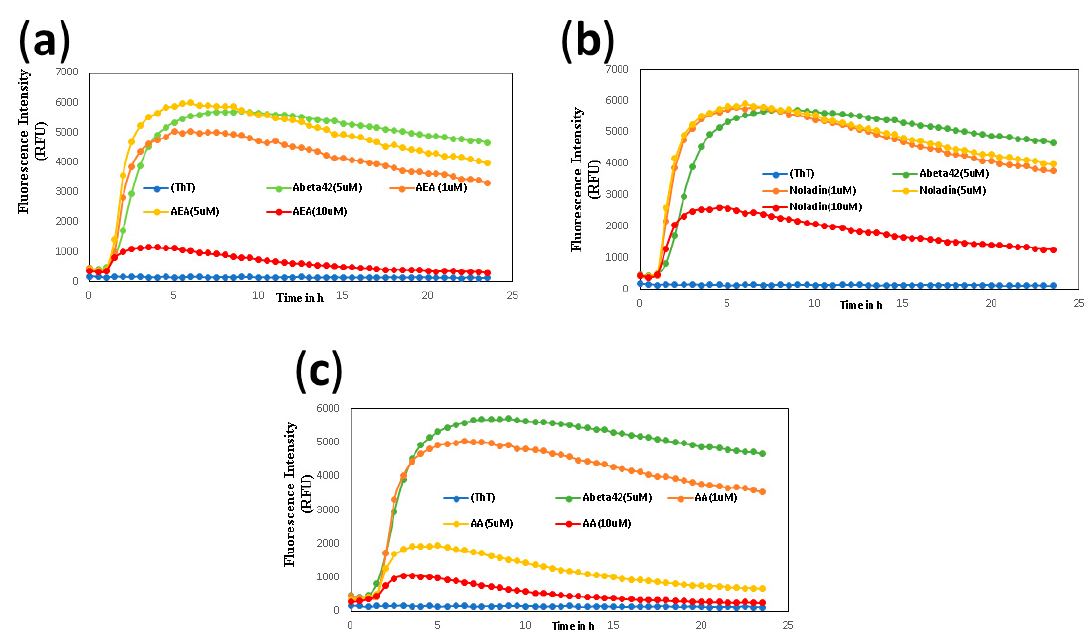
Figure 1. ThT-monitored 24 h aggregation kinetics of A β 42 (5 µ M) in the presence of 1, 5, 10 µ M of AEA ( a ) Noladin ( b ), and AA ( c ). Aggregation kinetics were monitored by ThT-fluorescence spectroscopy (excitation = 440 nm, emission = 490 nm) at pH 7.4, 37 ◦ C in phosphate buffer. Results are the average ± SD of three replicates.